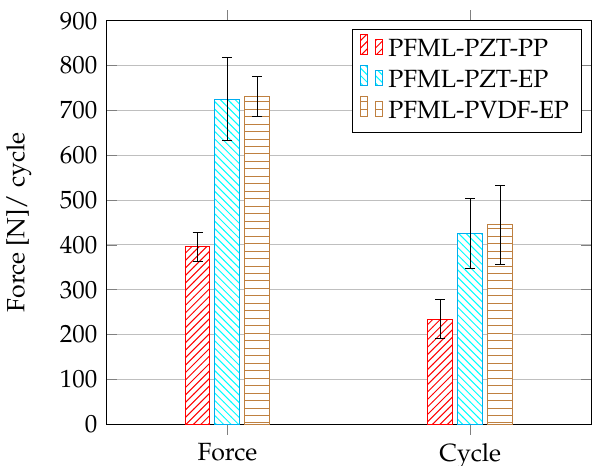
Figure 9. Comparison of the maximum values: force and cycles from the dynamic three-point bending test.